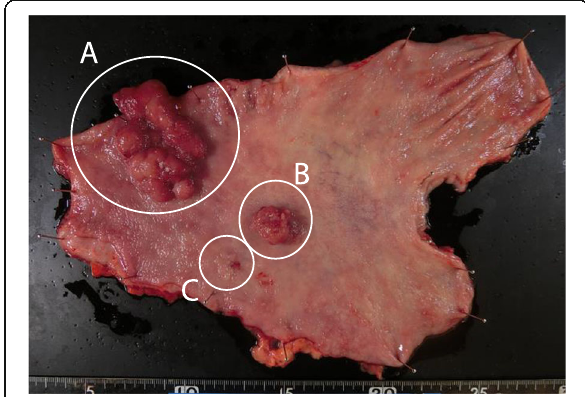
Fig. 3 Surgically resected specimen. Tumor in the anterior wall of the gastric body ( a ) with daughter nodules ( b , c )